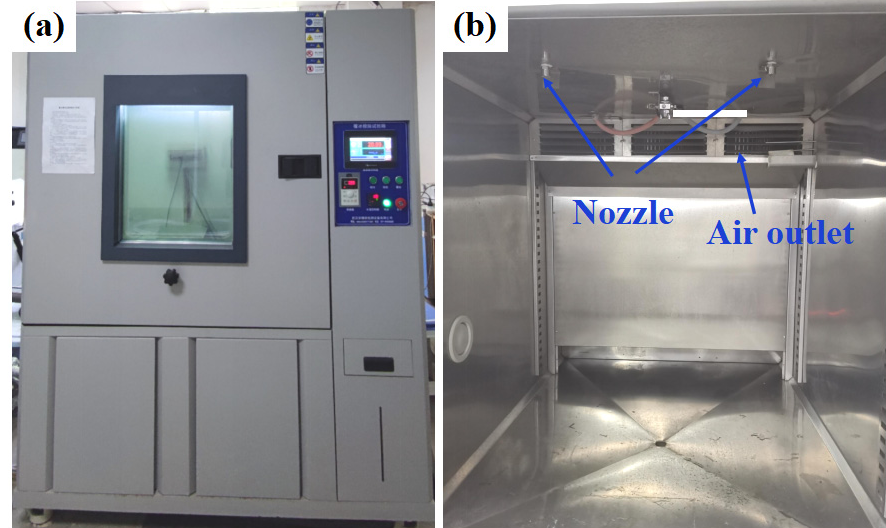
Figure 7. The appearance ( a ) and internal structure ( b ) of the arti fi cial icing climate chamber.